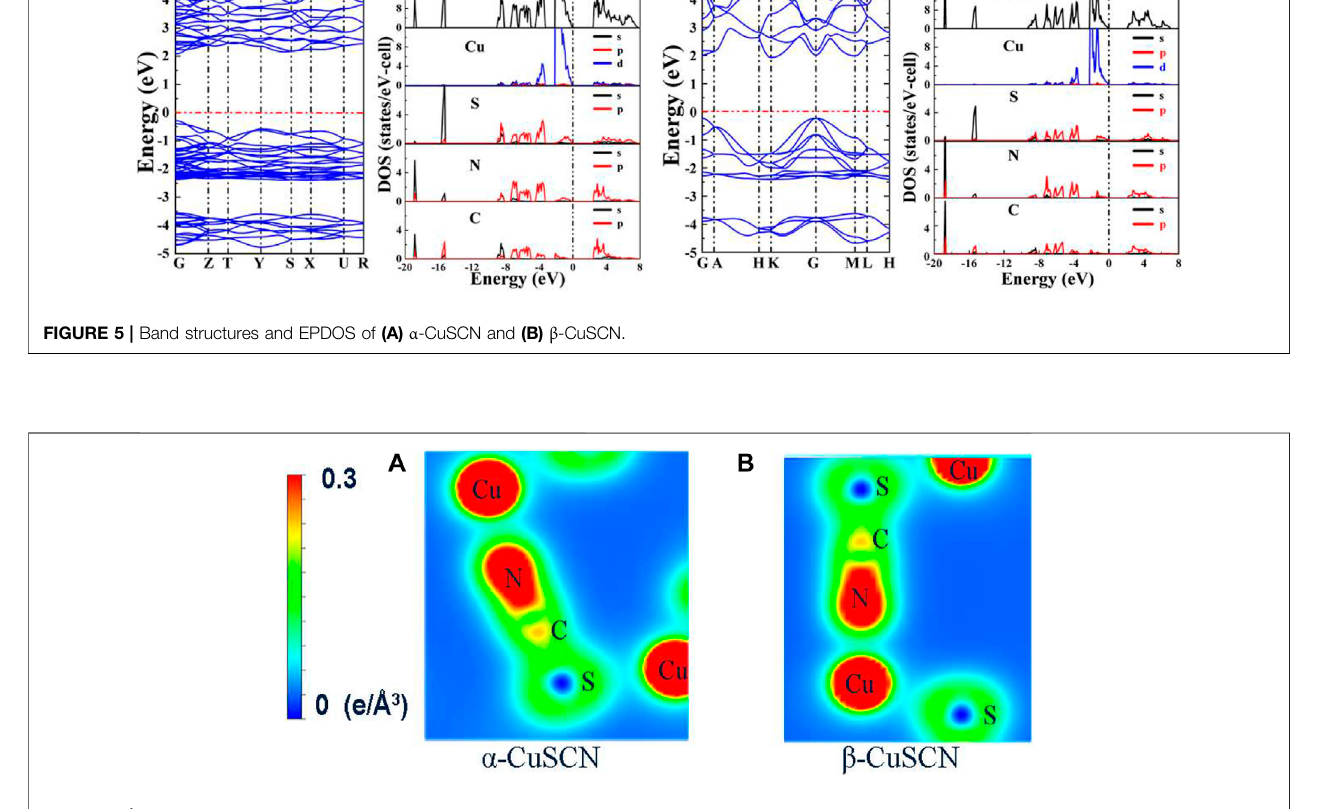
FIGURE 6 | Charge density in the Cu-N ≡ C-S section of (A) α -CuSCN and (B) β -CuSCN.